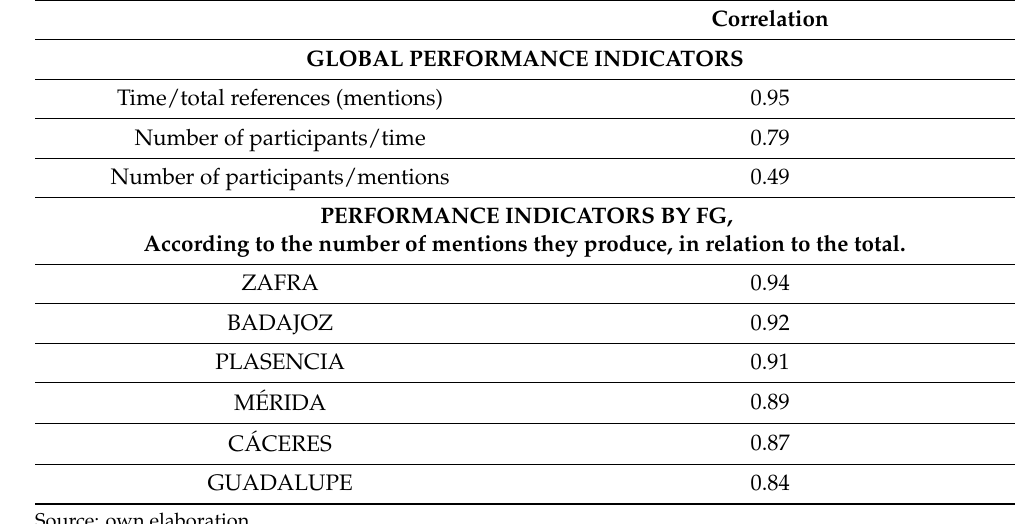
Table 5. Focus group performance